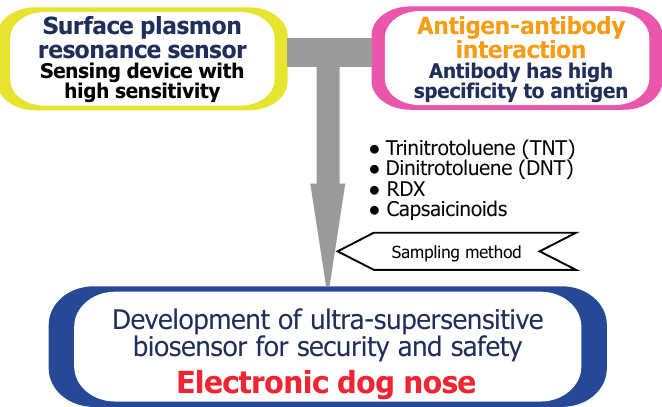
Figure 1. Composition of an electronic dog